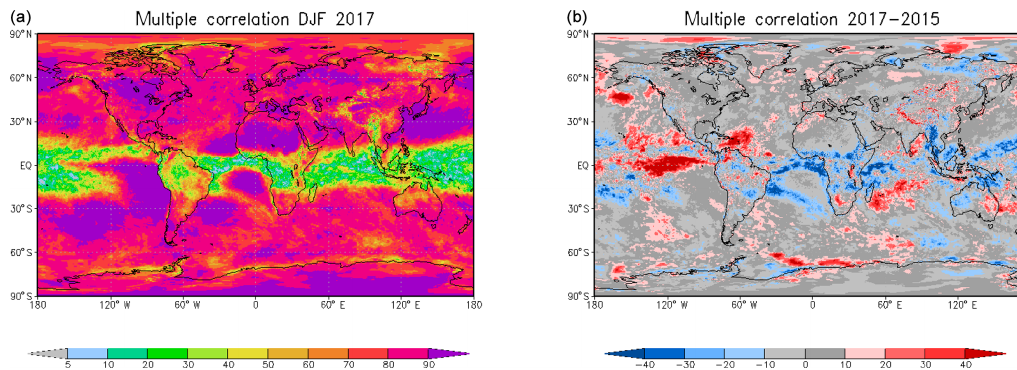
Figure 4. Squared multiple correlations between ECMWF reanalyses and ECMWF lead day 4 dynamic forecasts and damped lag day − 4 persistence forecasts for the winter (December–January–February – DJF) of 2016–2017 (a) . Differences between the multiple correlation coefficients for the winters of 2016–2017 and 2014–2015 (b) . Assuming a Student t distribution of the R 2 estimates, and about 18 degrees of freedom, the confidence intervals R 2 (in percentages) are 22 < 60 < 83, 35 < 70 < 86 and 55 < 80 < 92.